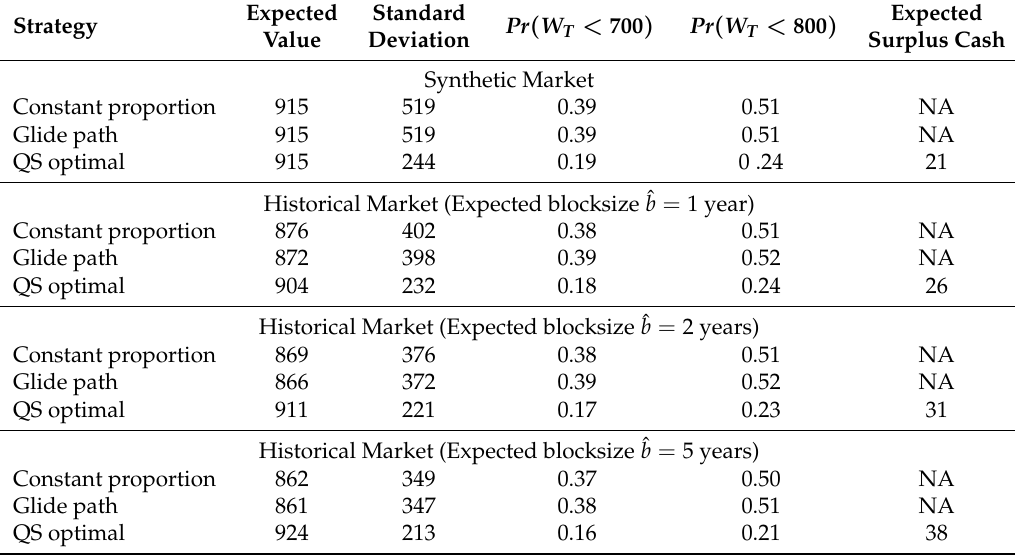
Table 3. Base case scenario results. Wealth units: thousands of dollars. Input data provided in Tables 1 and 2. Synthetic market results computed using Monte Carlo simulations with 160,000 sample